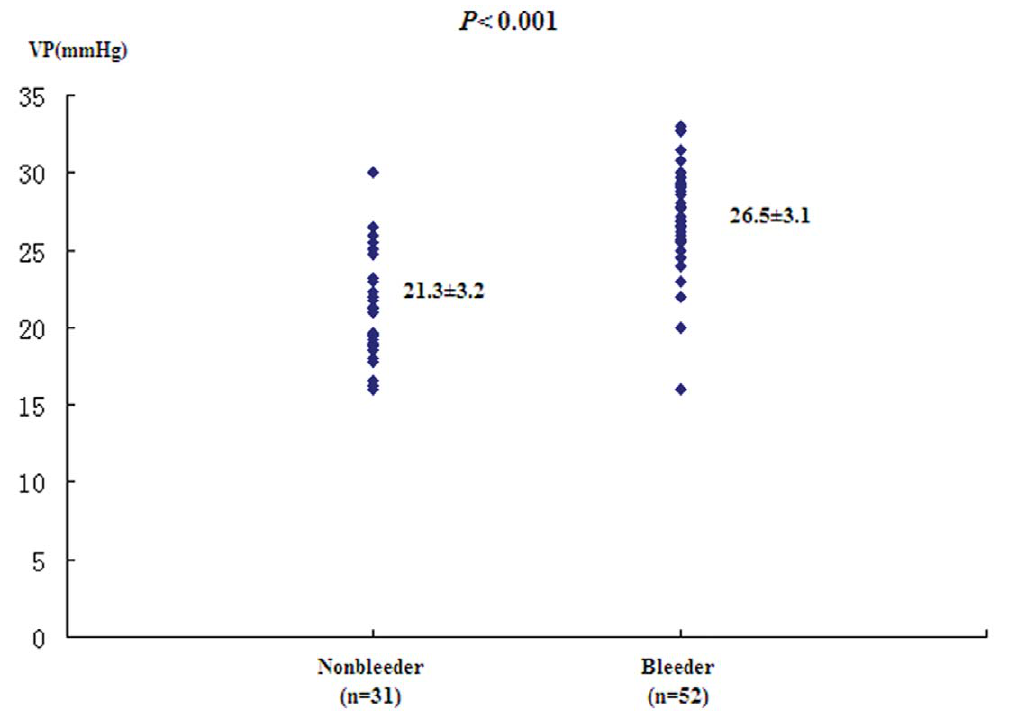
Figure 6. VP levels (mm Hg) measured by CEBM in patients with middle/small and large esophageal varices.